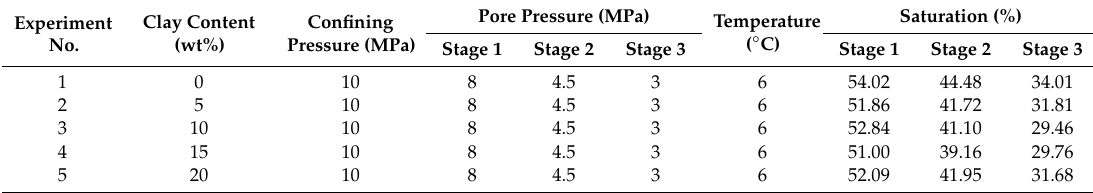
Table 1. Sample parameters for shear experiments (Nos.